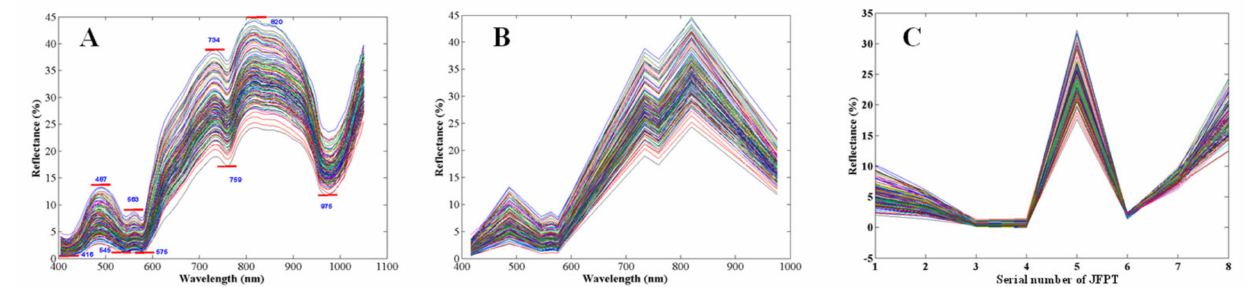
Figure 4. Peak and troughs featured in the spectral range of 400–1050 nm. ( A ), Peaks and troughs in raw spectral data; ( B ), virtual spectrum composed of peaks and troughs; ( C ), peak-trough jump features formed by the difference between peaks and troughs, spectral curves of different color come from different